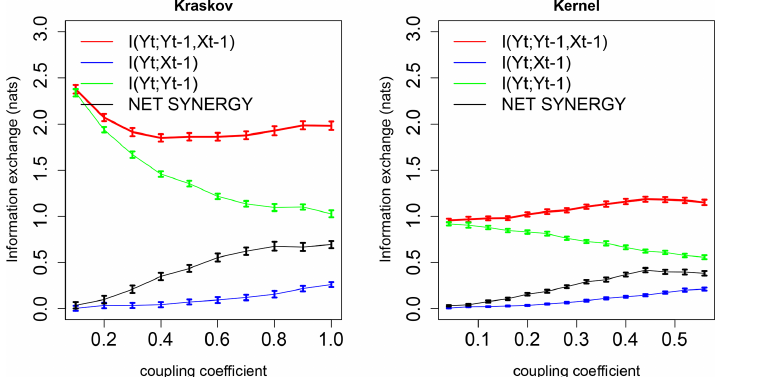
Figure A1. Information exchange in nats from two sources (red line), a single source (green and blue lines), and net synergy (black line) to target for Kraskov and kernel estimators. The error bars represent 2 standard deviations of the 100 permuted samples.